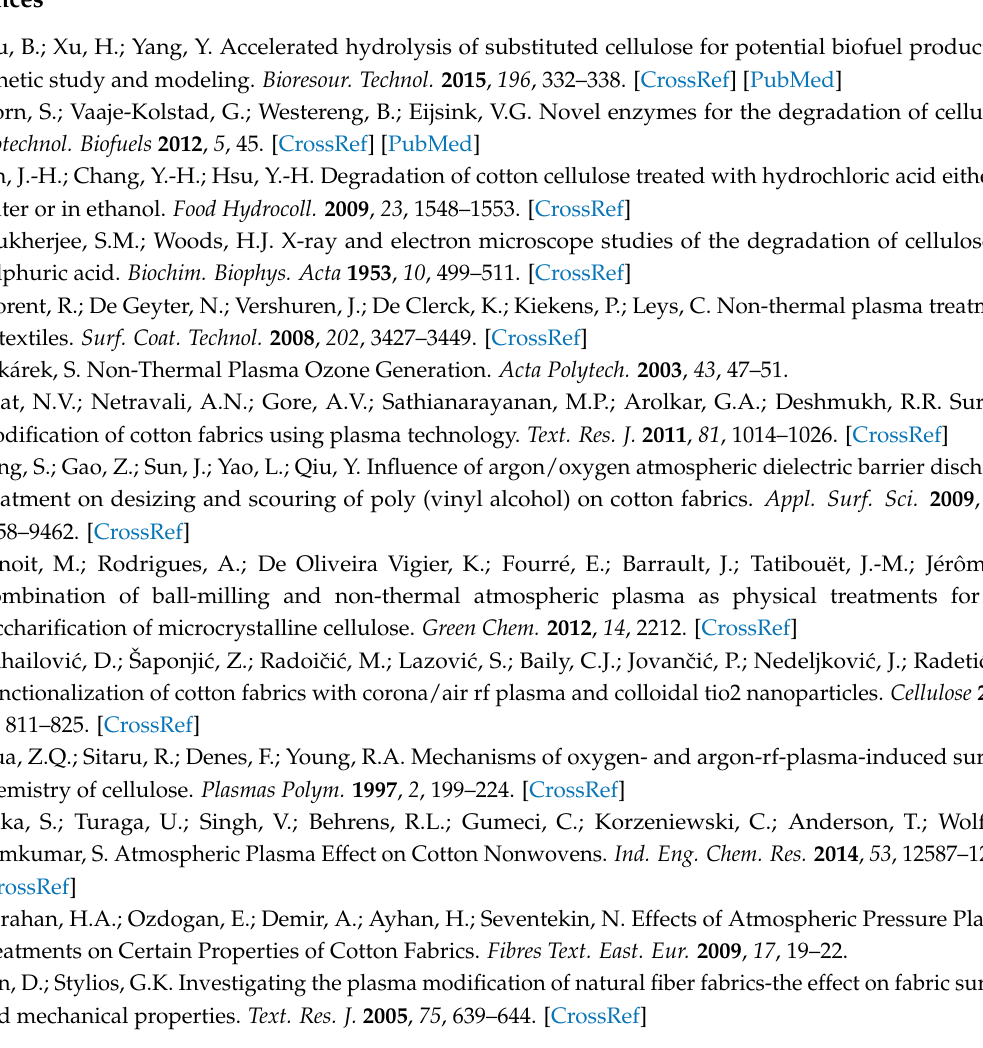
Table S1: All experimental conditions performed on greige and scoured yarns, Video S1: Video of the visual degradation of yarns after 90 min of O 2 plasma treatment using a power density of 0.46 W/cm 2 , Figure S1: XPS data of C1s with four deconvoluted peak fittings for ( a ) control greige yarn, ( b ) control scoured yarn, ( c ) greige yarn treated at 0.46 W/cm 2 for 60 min, and ( d ) scoured yarn treated at 0.46 W/cm 2 for 60